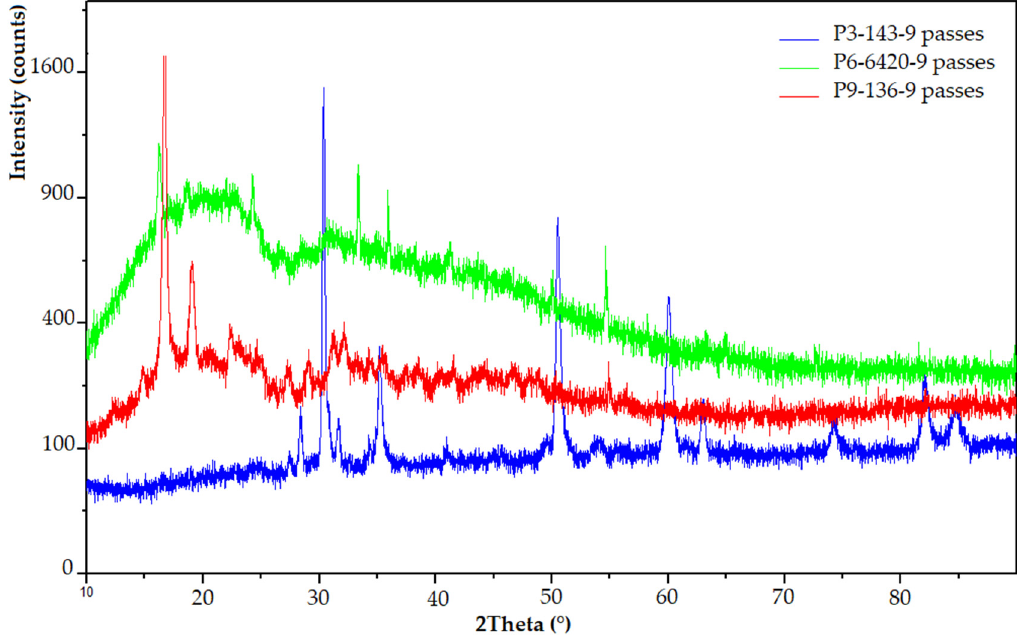
Figure 7. XRD analysis for ceramic coated samples: P3–143–9 passes (blue), P6–6420–9 passes (green), P9–136–9 passes (red).